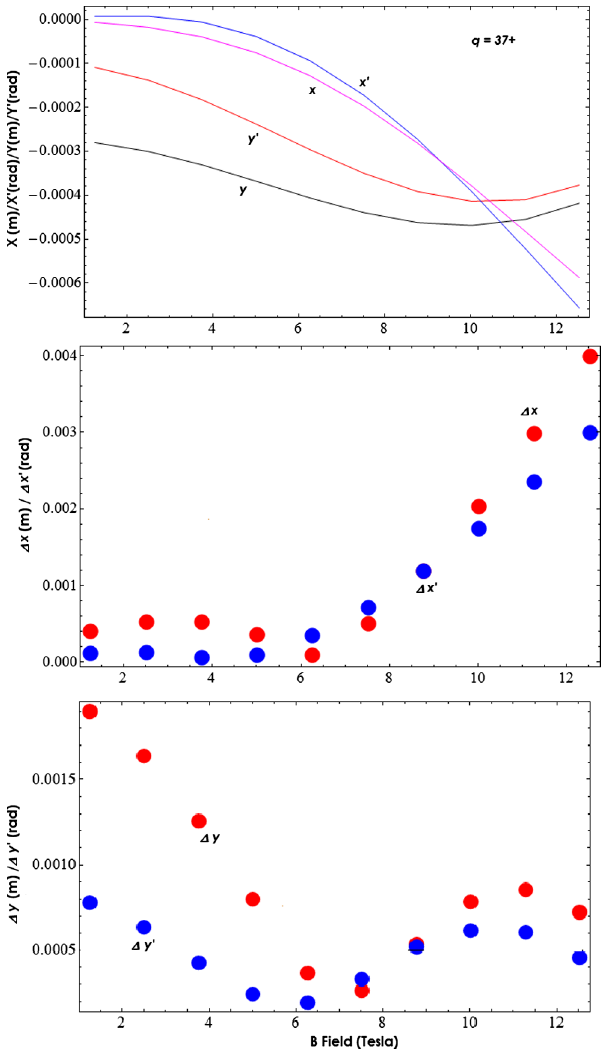
FIG. 4. Variation of beam coordinates and divergence of 37 þ and range spanned by different charge states at end of APF#2 with solenoid